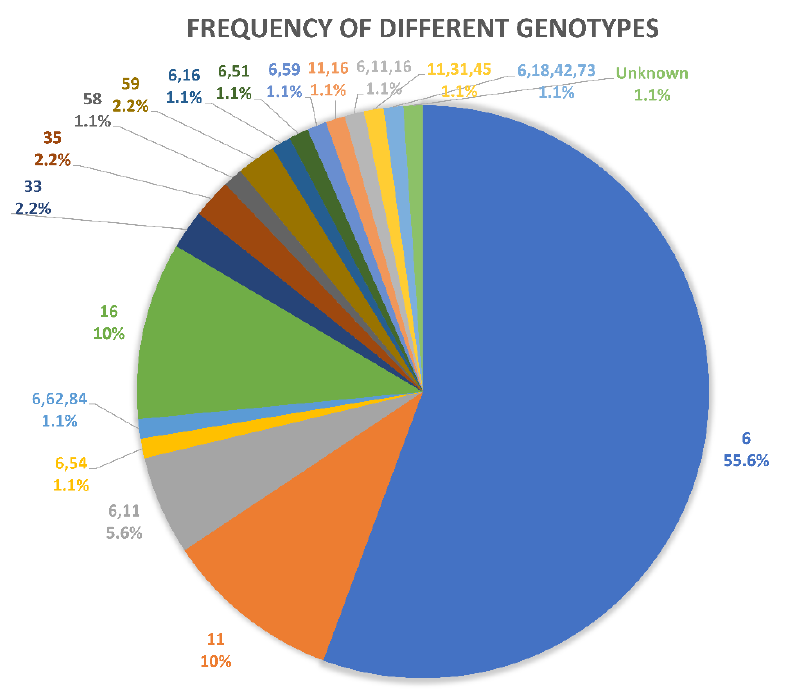
Figure 1. Frequency of HR-HPV & LR-HPV and Mixed groups. Considering the location, the most frequent LR-HPV genotypes were described in the cervix and anus (31.8% each), and the cervix dominated the HR-HPV (87.5%) and mixed genotype (42.9%), (Figure 2), χ 2 test used, p = 0.015.